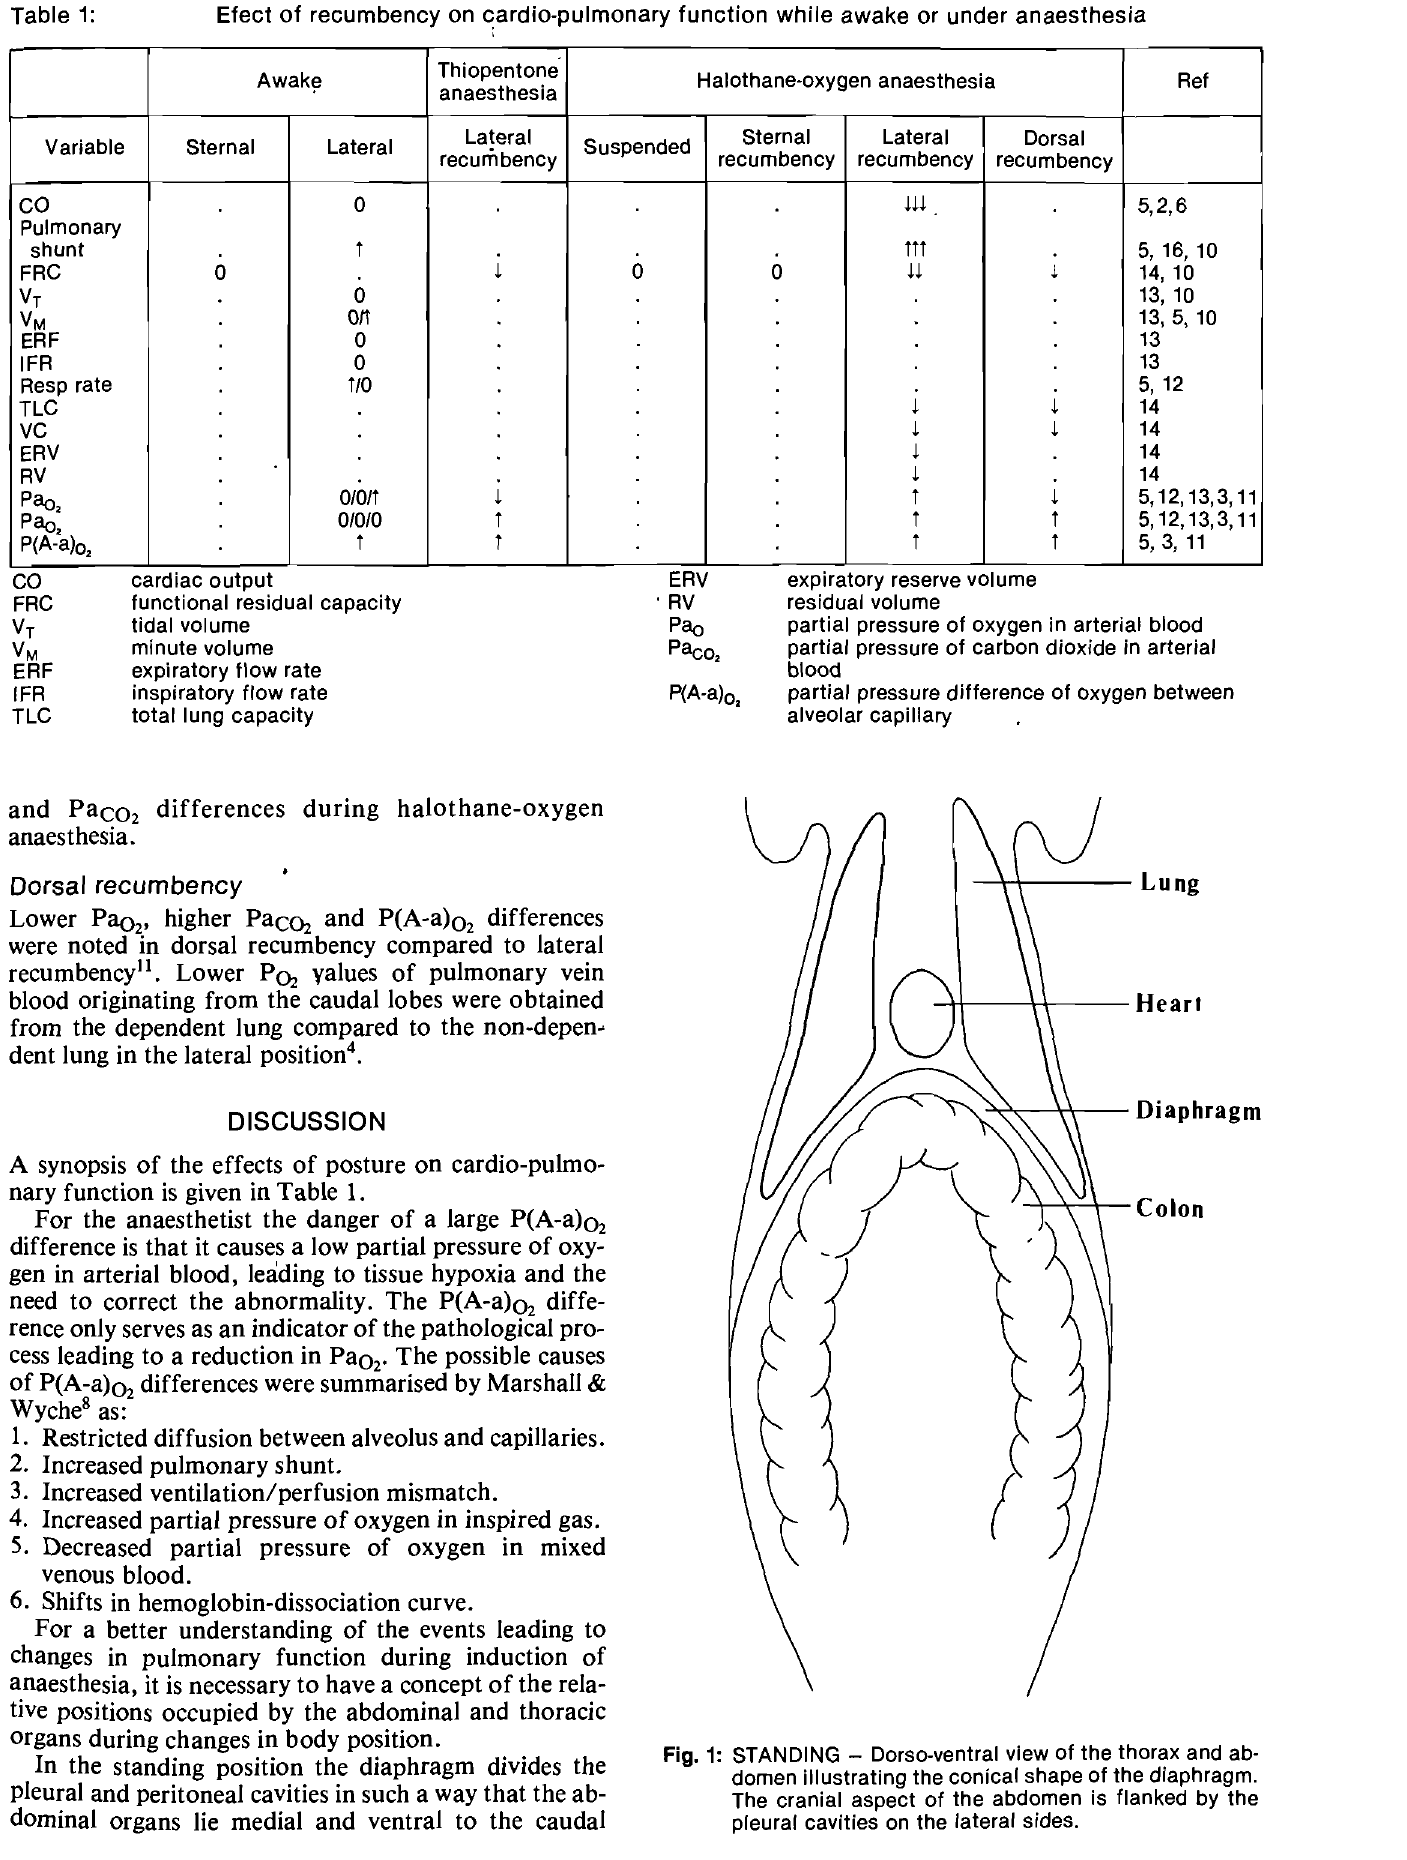
Fig. 1: STANDING - Dorso-ventral view of the thorax and ab domen illustrating the conical shape of the diaphragm, The cranial aspect of the abdomen is flanked by the pleural cavities on the lateral